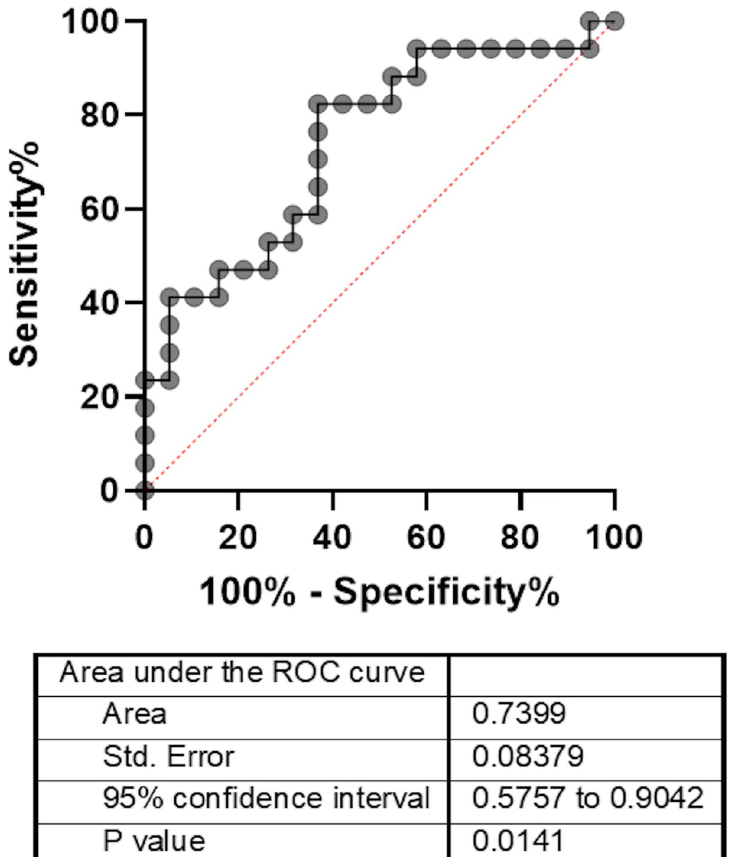
Fig 3. AUROC of angiogenin for TIPS dysfunction. The area under the ROC curve of angiogenin for TIPS dysfunction was 0.74 (0.6–0.9); P = 0.01. TIPS: Transjugular intrahepatic portosystemic shunt. n = 36.